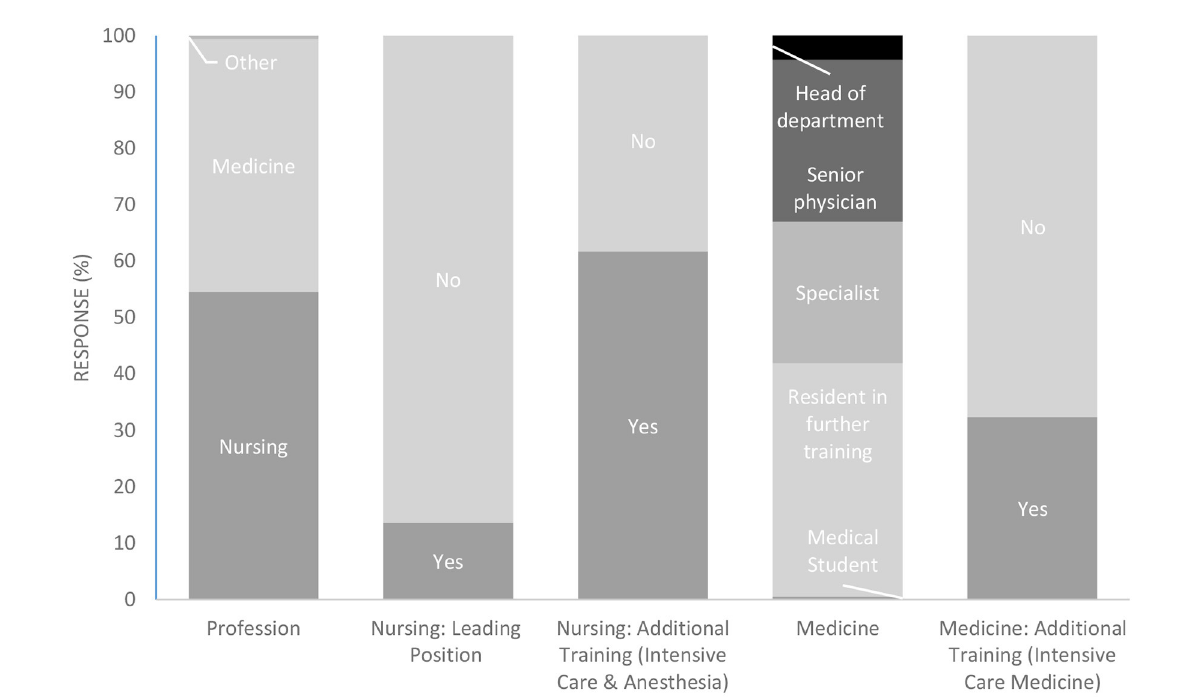
FIGURE4 Demographics of medical and nursing staff. Participants were asked about their professional group affiliation (column 1). Nursing staff was asked whether they held a leading position (column 2) and whether they had advanced specialist training in anesthesia and intensive care (column 3). Medical staff was asked about their position (column 4) and whether they had an additional training in intensive care medicine (column 5). Response rates are given in percentage terms for each item.